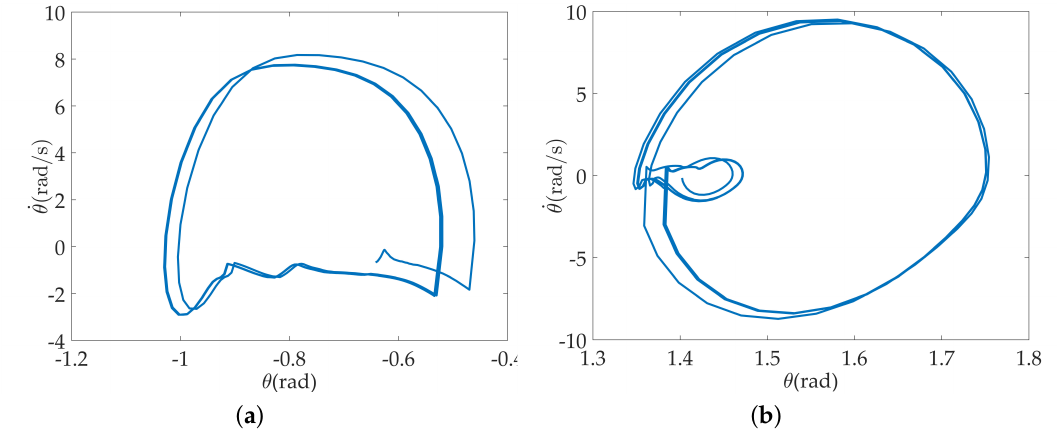
Figure 11. ( a ) Phase portrait of the hip joint in the simulation; ( b ) Phase portrait of knee joint in the